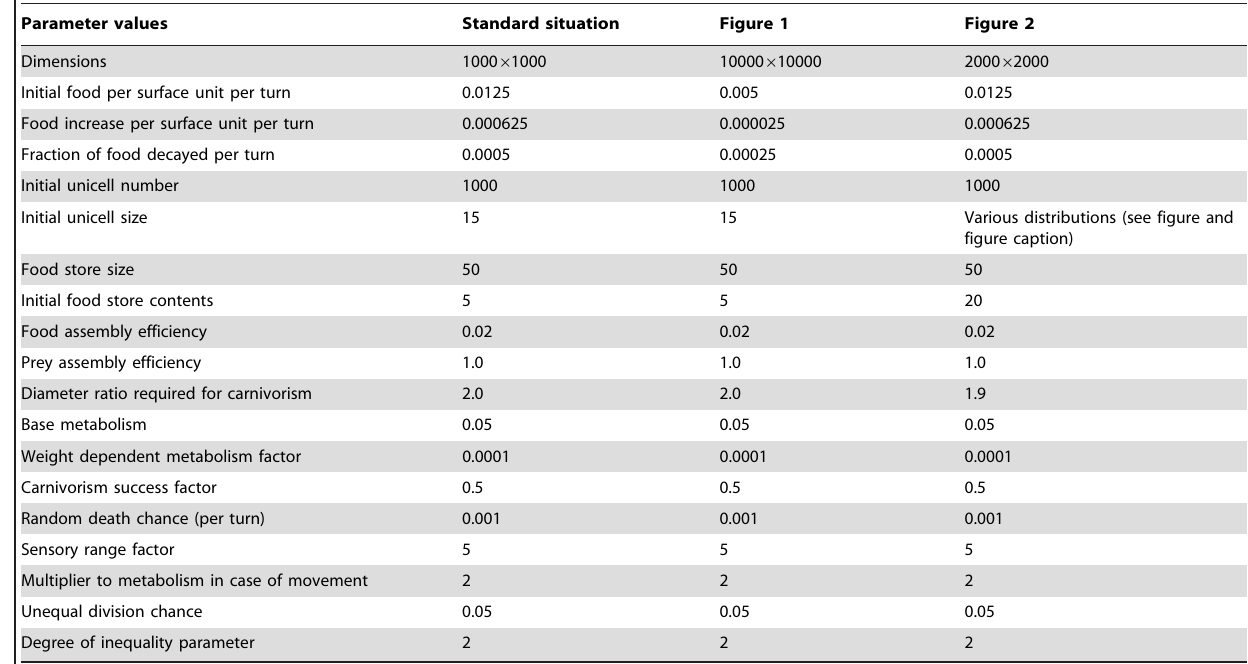
Parameter values Standard